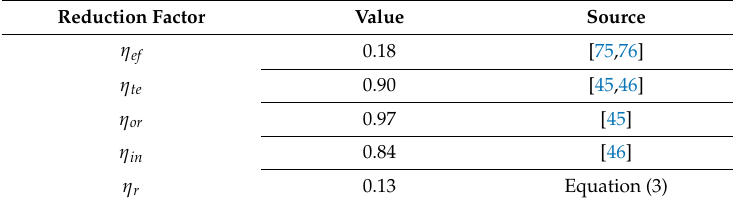
Table 7. The factors that reduce the solar